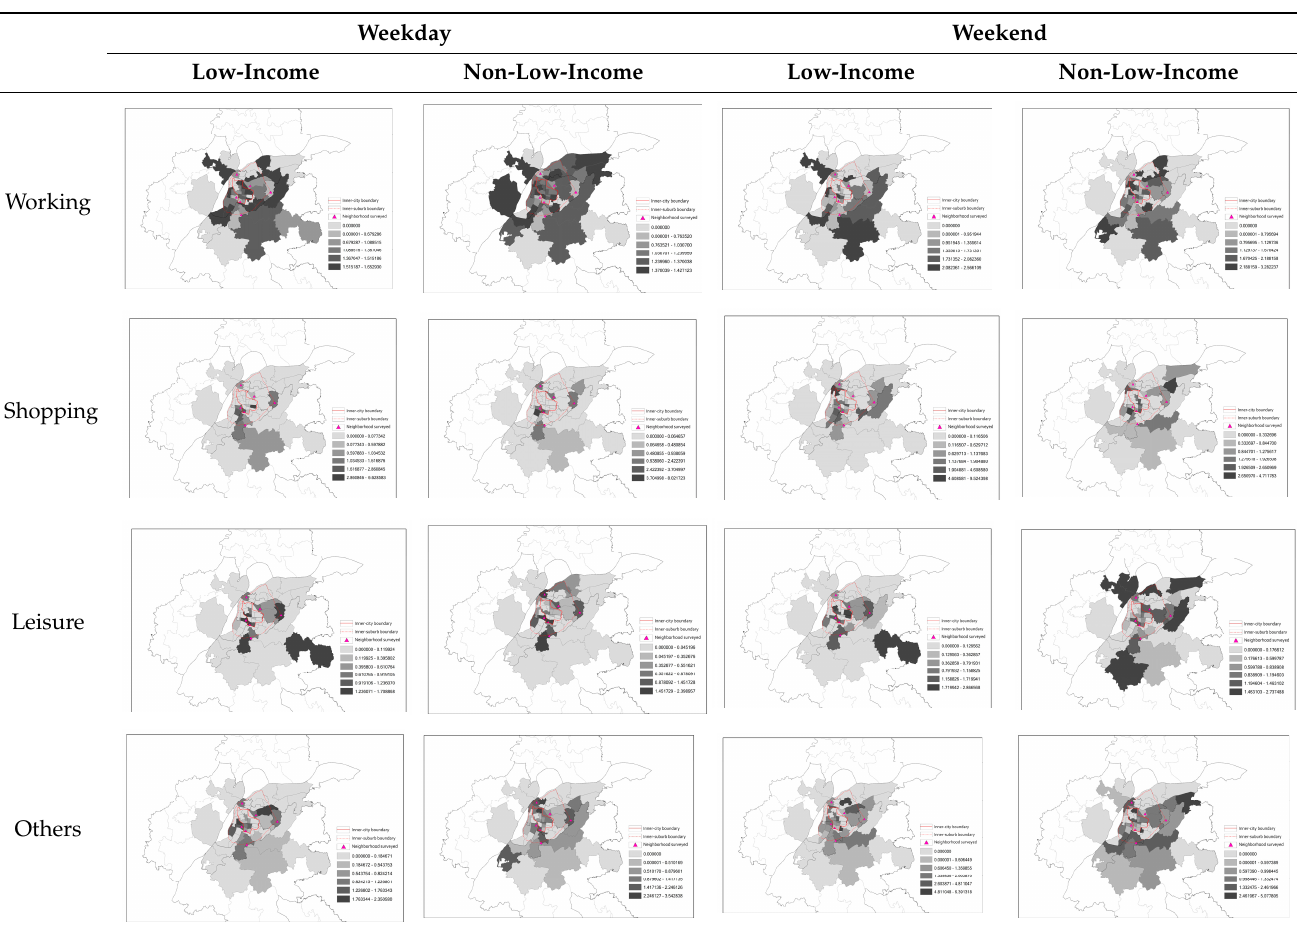
Table 4. Temporal distribution of the out-of-home activities of the two income groups by urban space.